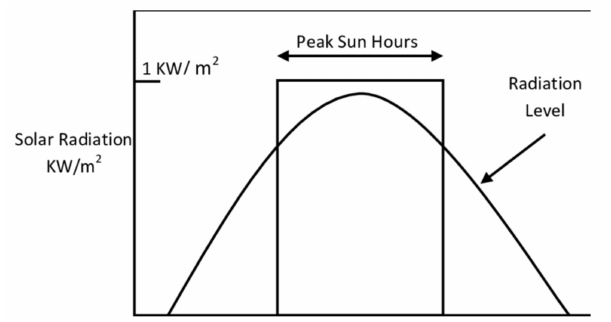
Figure 8. Peak sun